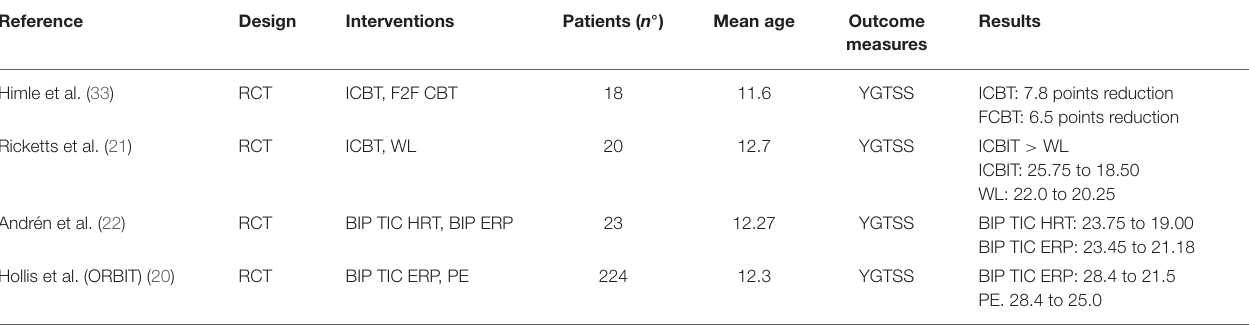
TABLE 3 | Summary of studies on online-remote BT in pediatric TS